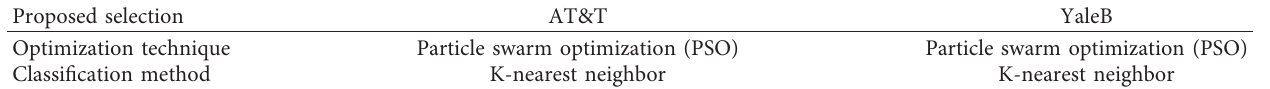
Table 11: Proposed classification and optimization techniques for both